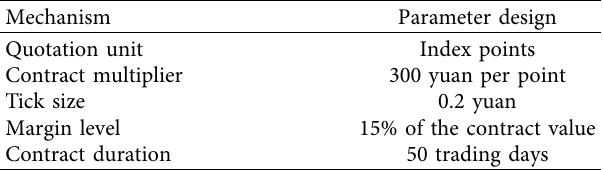
Table 2: Stock index futures contract in the agent-based